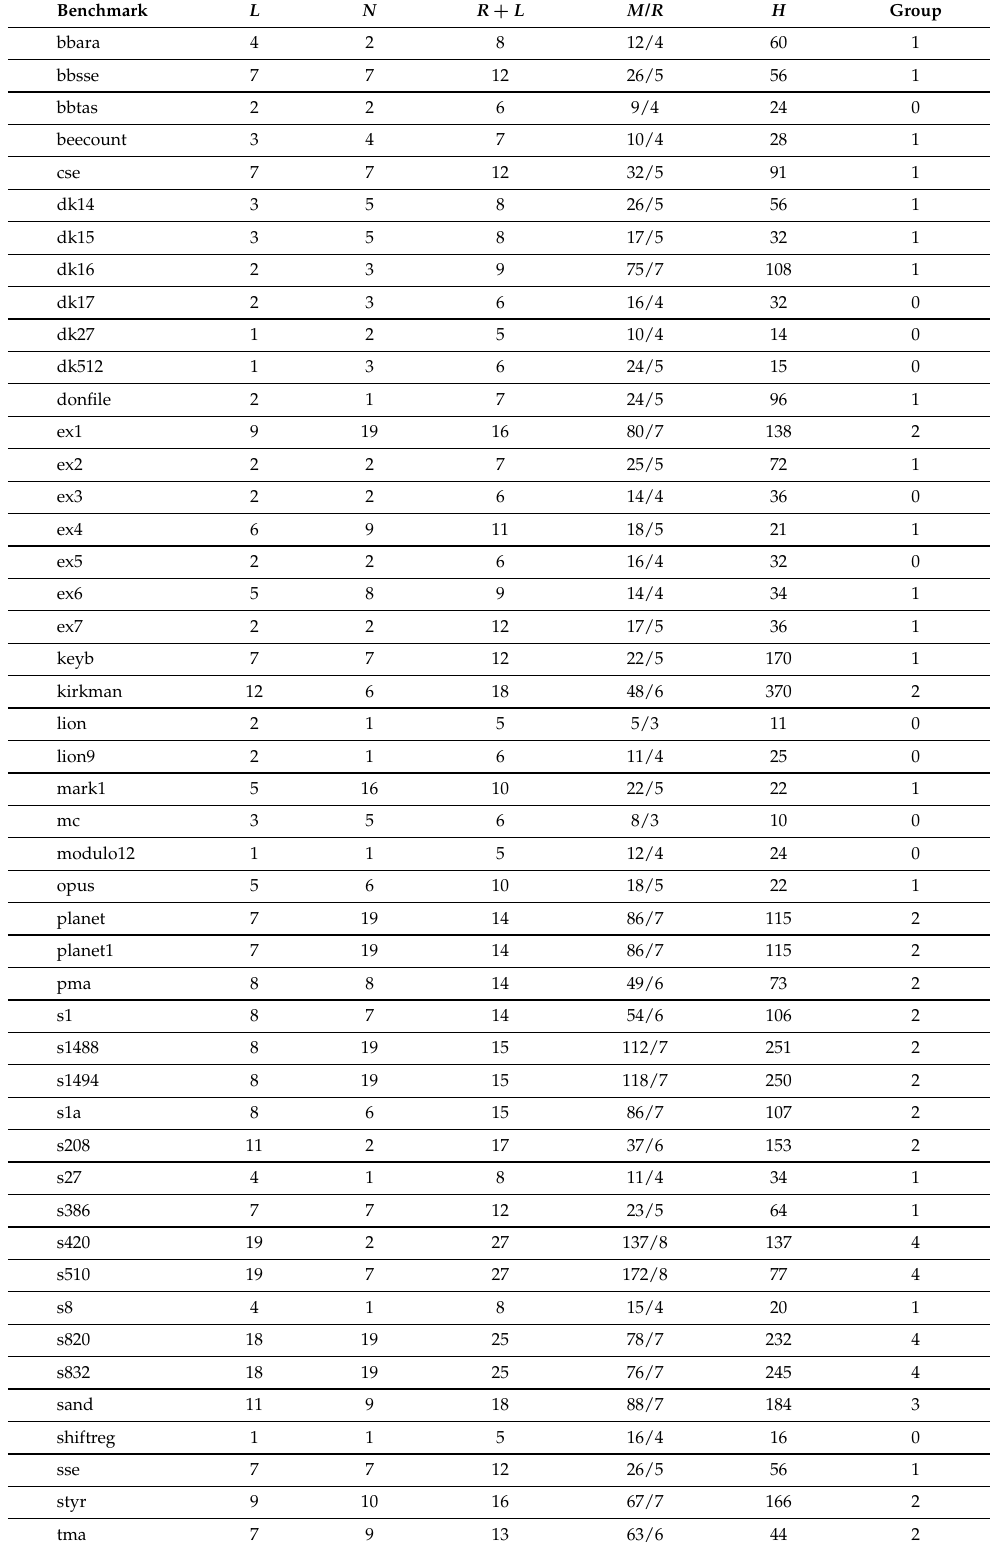
Table 7. Basic characteristics of benchmarks from library